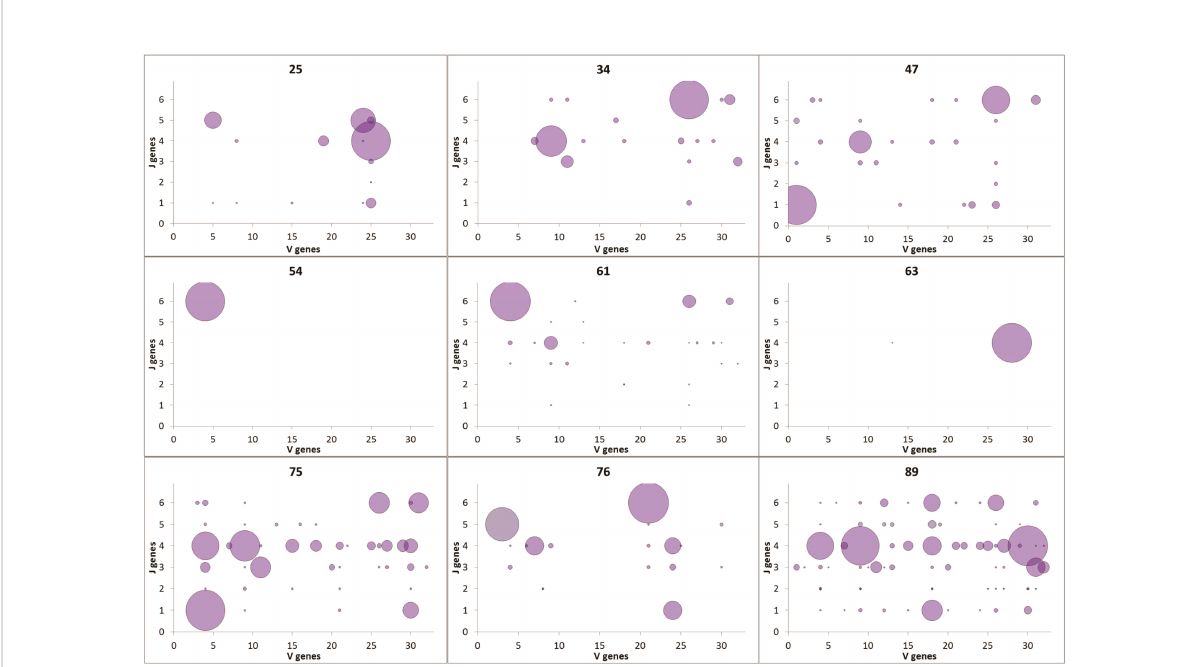
FIGURE 3 VJ combination usage. V genes are plotted on the x-axis; J genes are plotted on the y-axis. The size of each point represents the number of unique sequences with the particular VJ pairing.